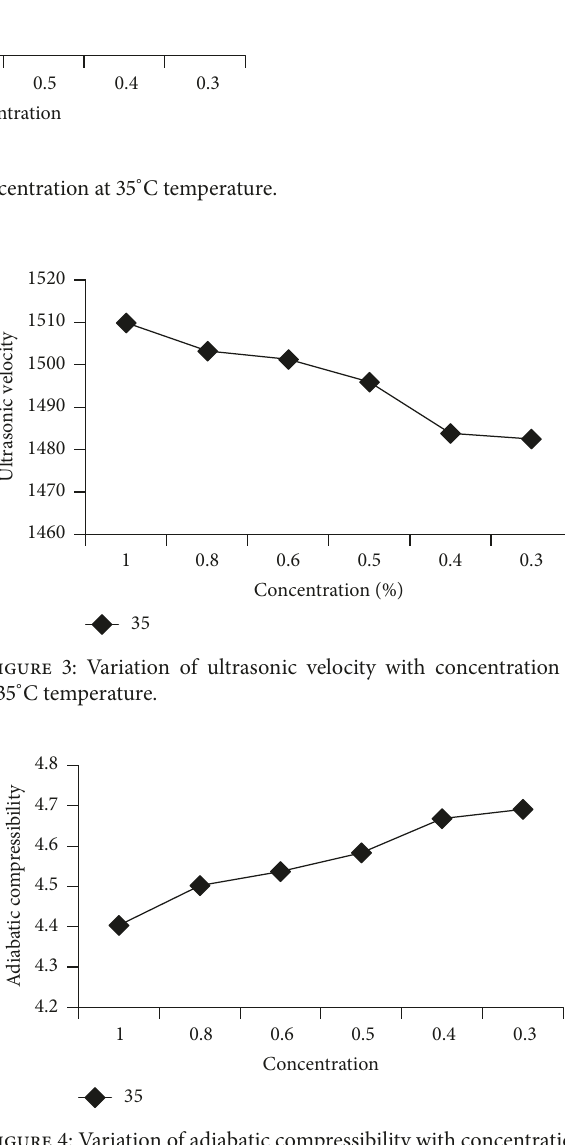
Figure 4: Variation of adiabatic compressibility with concentration at 35 ∘ C